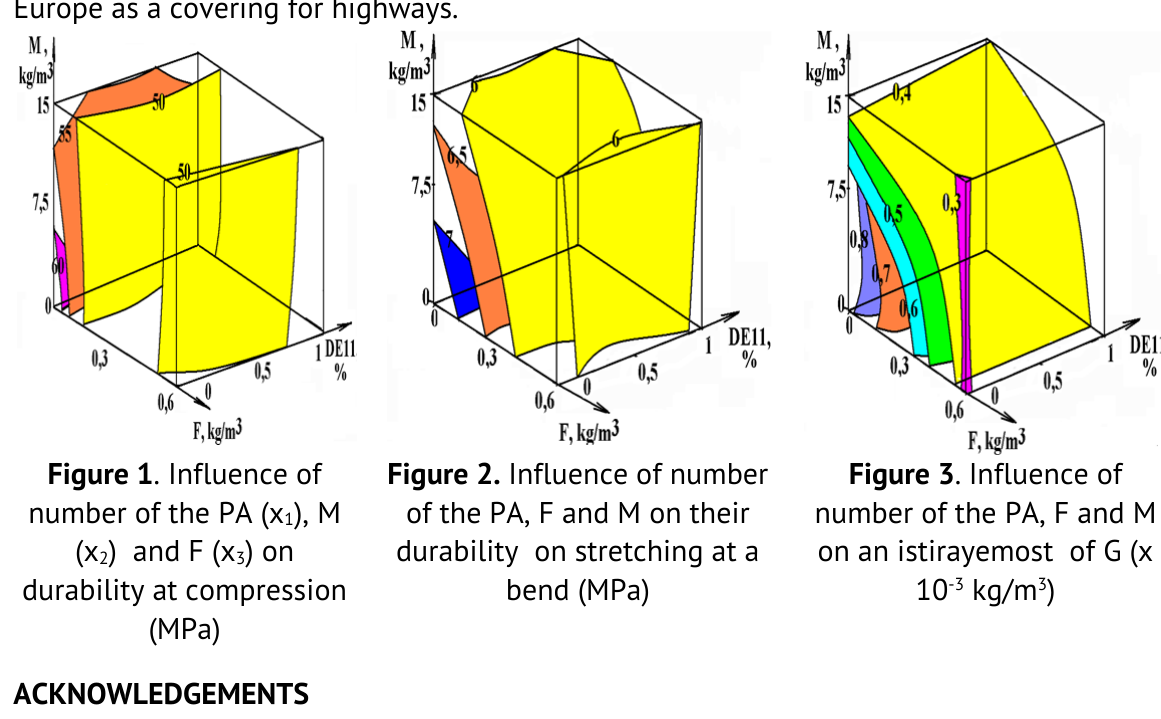
Figure 1 . Influence of Figure 2. Influence of number number of the РА (x ), M of the РА , F and M on their 1 durability on stretching at a (x ) and F (x ) on 2 3 durability at compression bend (MPa) (MPa)